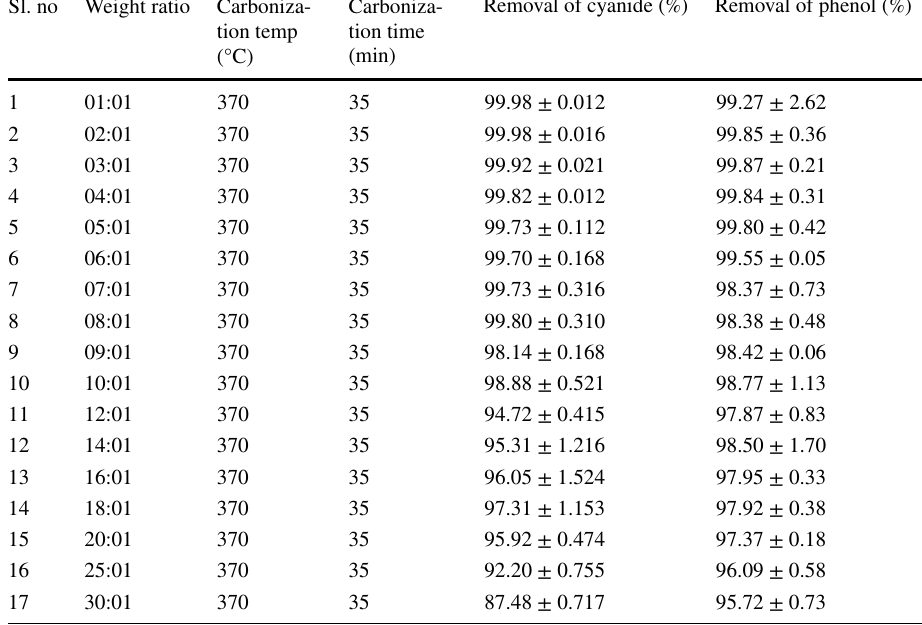
Table 1 Percentage removal of cyanide and phenol with various weight ratios of prepared carbonized